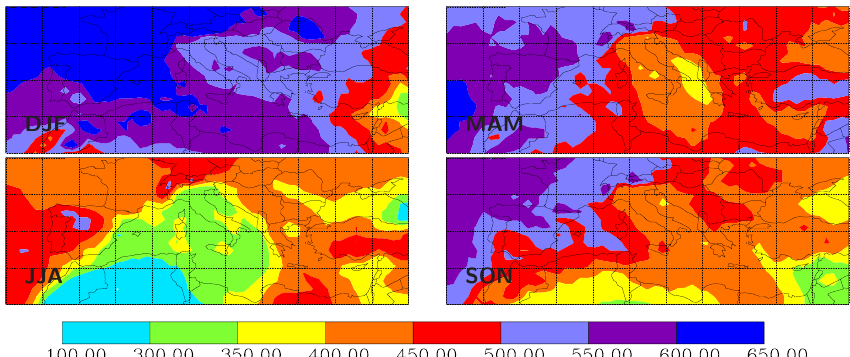
Fig. 5. Seasonally averagered one-day stagnation/ventilation results in the Mediterranean basin, units of km (small values indicate strong stagnation).